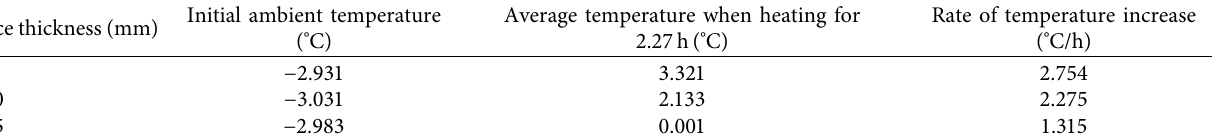
Table 11: Rate of temperature increase of the specimen surface with different ice